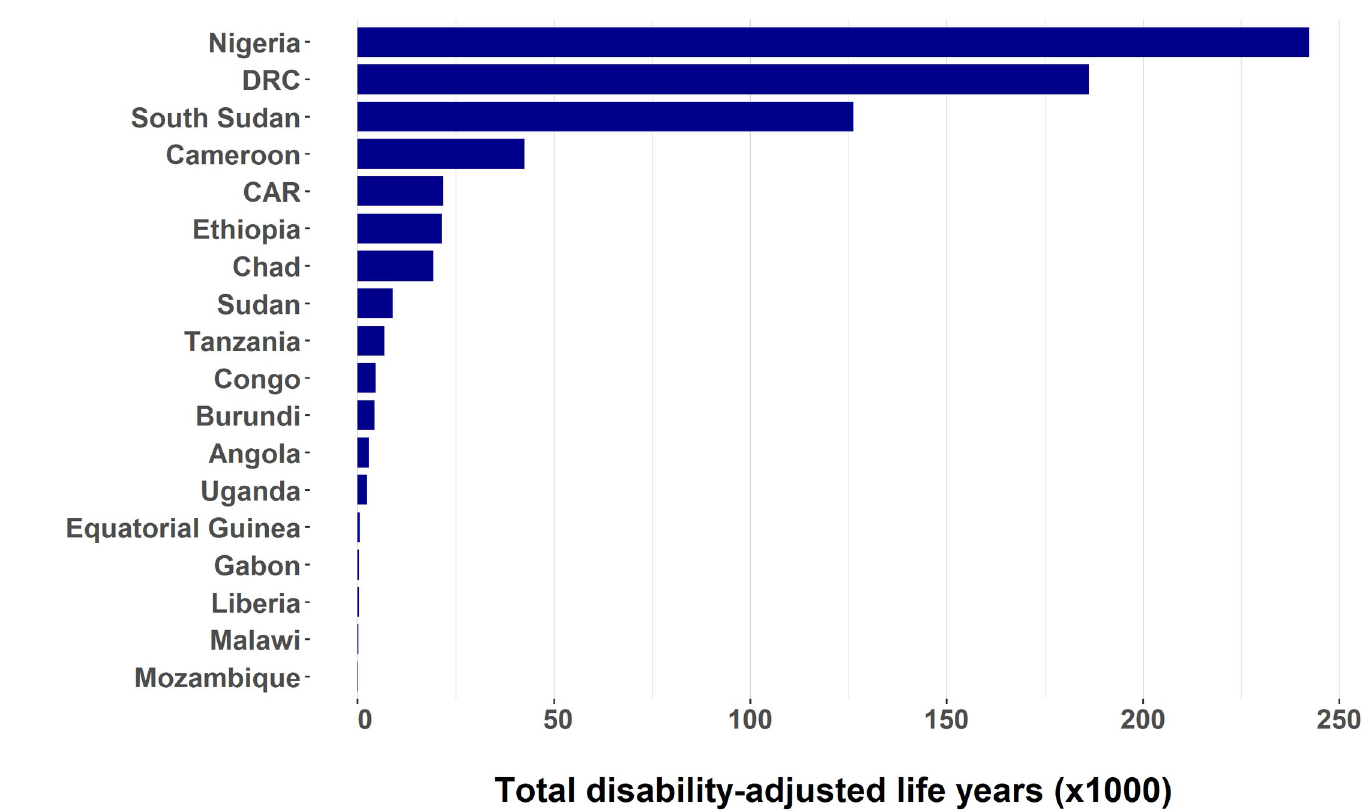
Fig 2. Total number of disability-adjusted life years (DALYs) lost due to onchocerciasis by country in 2030.